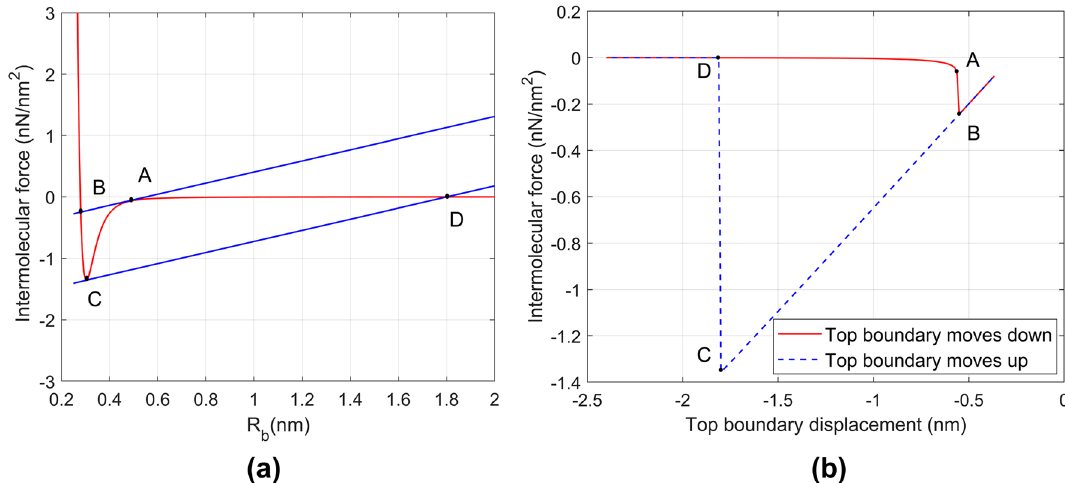
Figure 3. ( a ) Total bottom intermolecular force per unit area (red curve) vs intermolecular distance. The total elastic force per unit area in two instances are given by the blue curves. ( b ) Loading–unloading curve in massless and damper-less version of Fig. 1a showing hysteresis caused by the sudden intermolecular changes in force in ( a ) with same points A, B, C, D